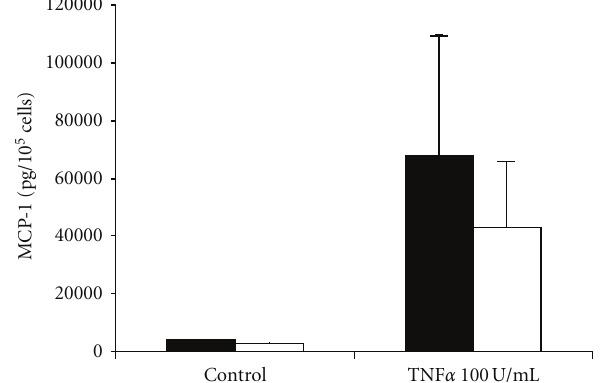
Figure 5: E ff ect of rosiglitazone on TNF α -induced enhancement of mesothelial MCP-1 secretion. MC were preincubated with rosiglitazone 10 μ M (white bars) or with control medium (black bars) for 24 hours. Afterwards, the culture media was replaced with media containing rosiglitazone 10 μ M (white bars) or not (black bars) to the given conditions. After an incubation time of 8 hours, culture supernatants were analysed by ELISA ( n =